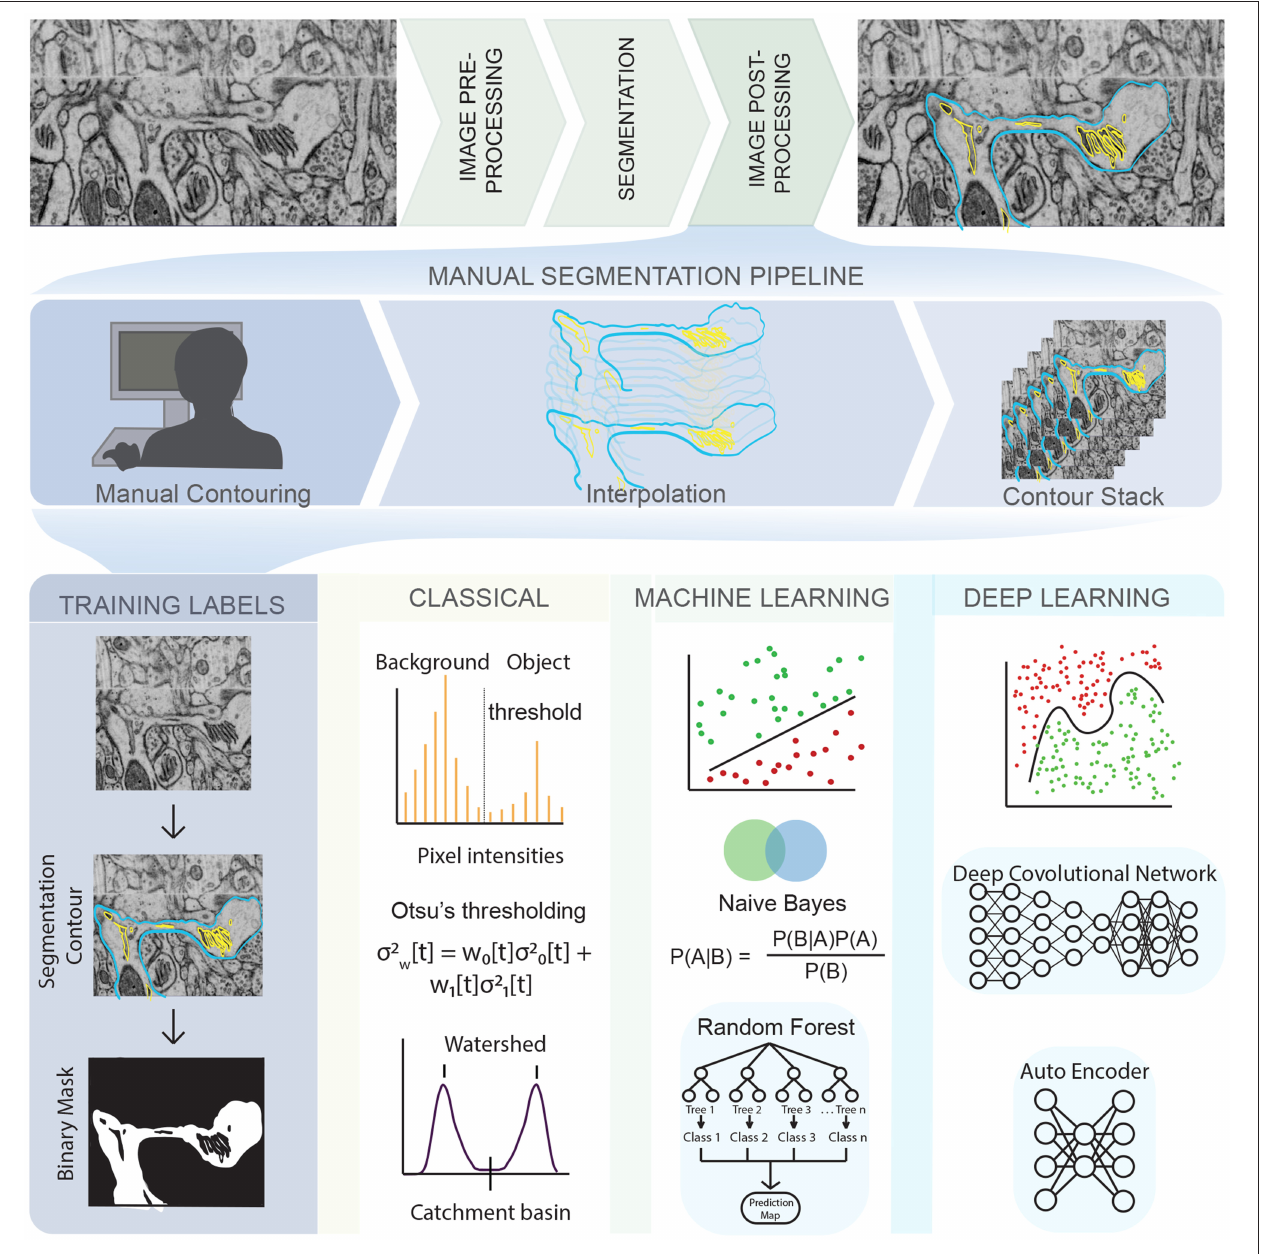
FIGURE 1 | An illustration of the complex pipeline needed to go from imaging data to a segmented mesh, with various opportunities for emerging techniques in machine learning shown throughout the pipeline. (Top row) EM images obtained from Wu et al. [24] of dendritic spines from mouse brain tissue. (Middle row) Manual tracing or contouring, interpolation, and stacking of contours is extremely time consuming, prone to error, and relies of human judgement. (Bottom row) On the other hand, development of training labels and different learning techniques can reduce both time and error, bridging the gap between biological data and simulations. Classical algorithms like Otsu’s thresholding and watershed are widely used and convenient but prone to error. Traditional machine learning algorithms like Random Forest and Naive Bayes are less prone to error and easy to use but require manual painting/interaction. Deep learning algorithms are highly effective and require no manual interaction but are limited by large training sets and compute resources. The list of techniques described is representative only, and not